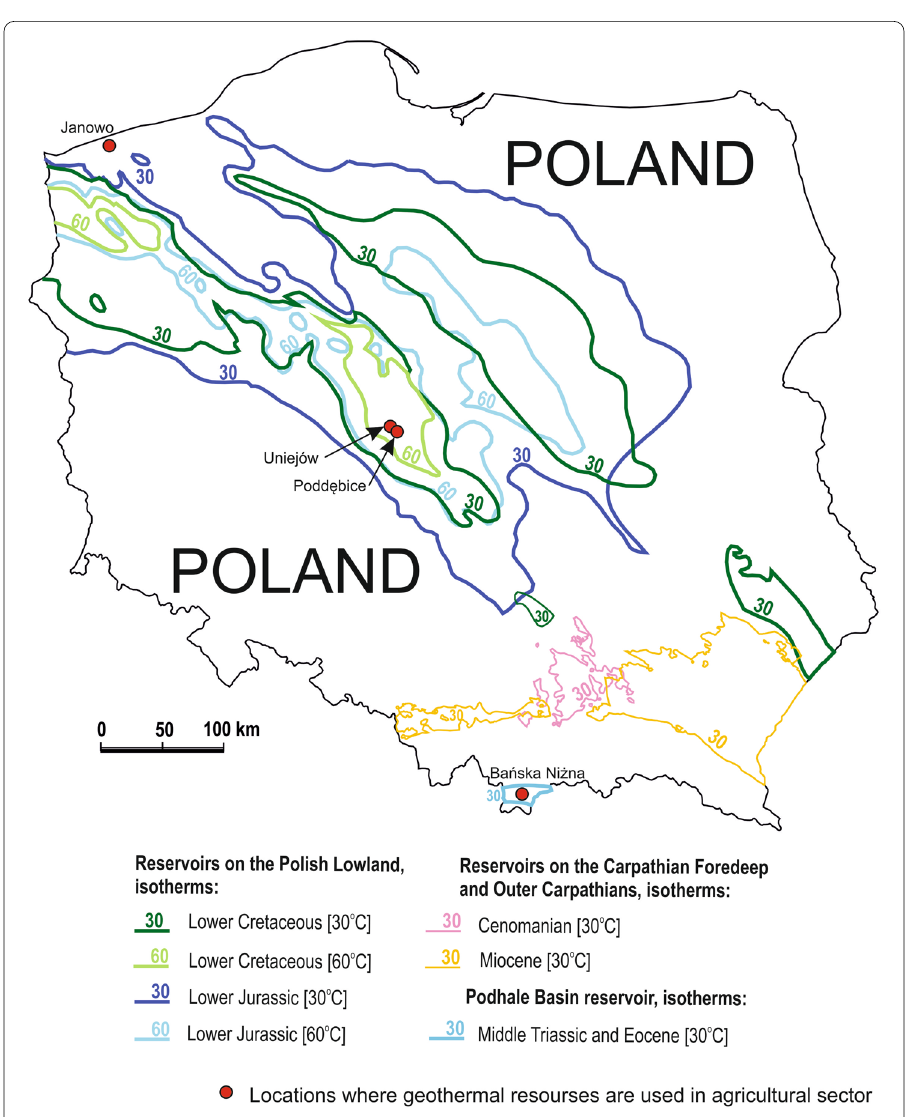
Fig. 1 Map of geothermal water reservoirs proposed for agricultural uses in Poland. Scientific description based on Barbacki et al. (2016) ; ranges of reservoirs with temperatures > 30 ◦ C and > 60 ◦ C according to maps by Górecki et al. (2006, 2011, 2012,